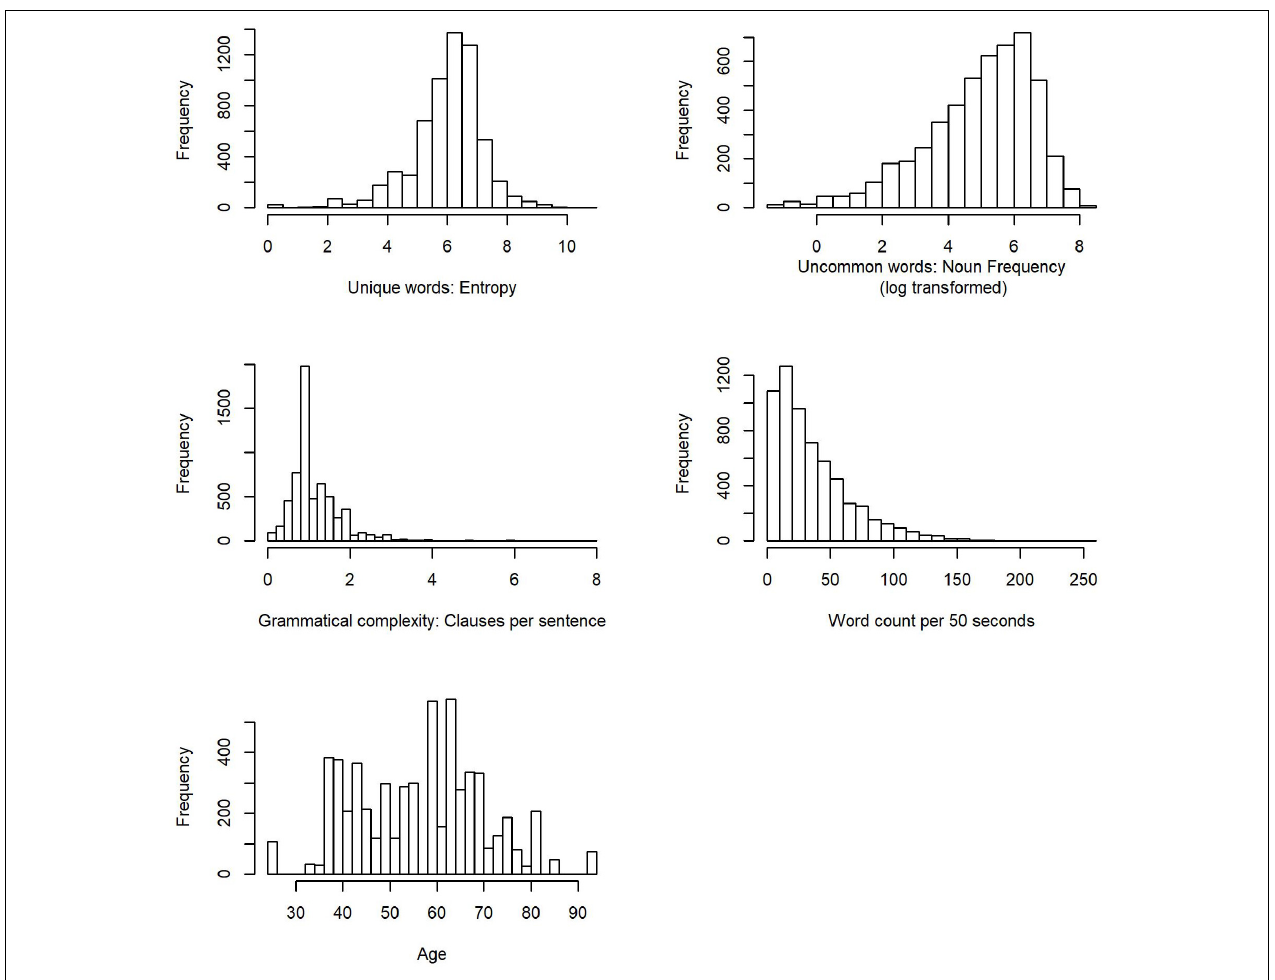
FIGURE 1 | Histograms of the linguistic measures and age.